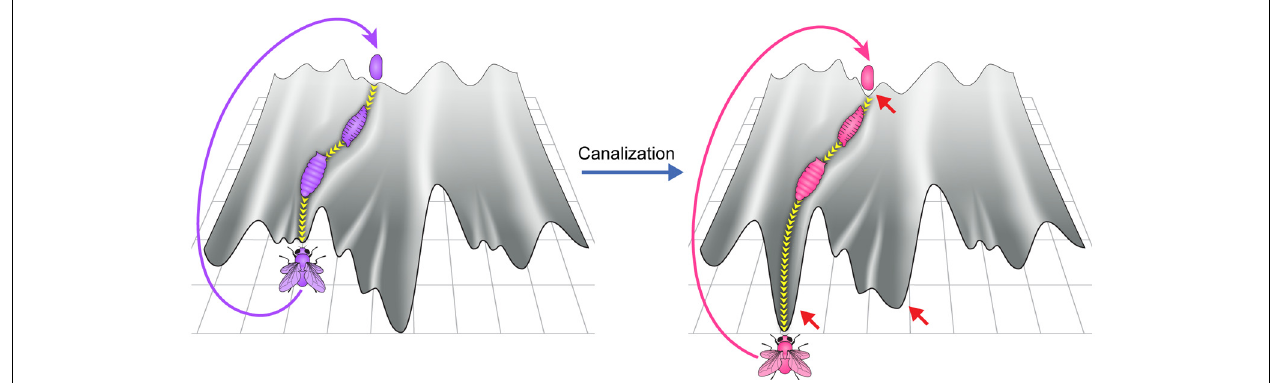
FIGURE 5 | Heuristic depiction of increased canalization over time in a new environment (right vs. left panel). The process of development becomes confined to a deeper and less rugged canal, reflecting, respectively,